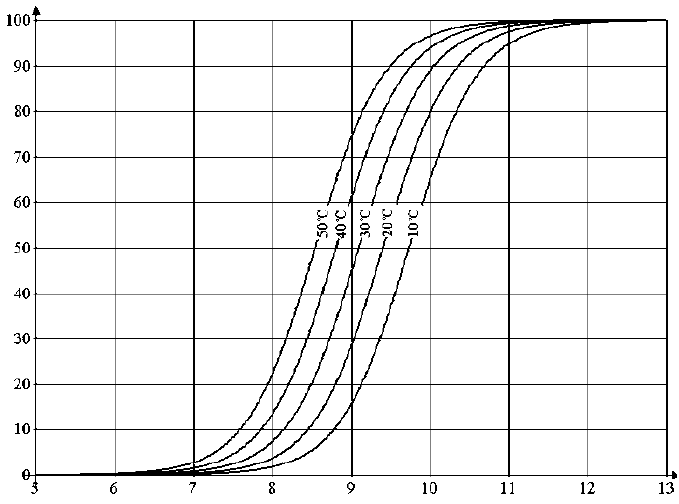
Figure 2. The proportion of free ammonia depending on pH and ambient temperature.